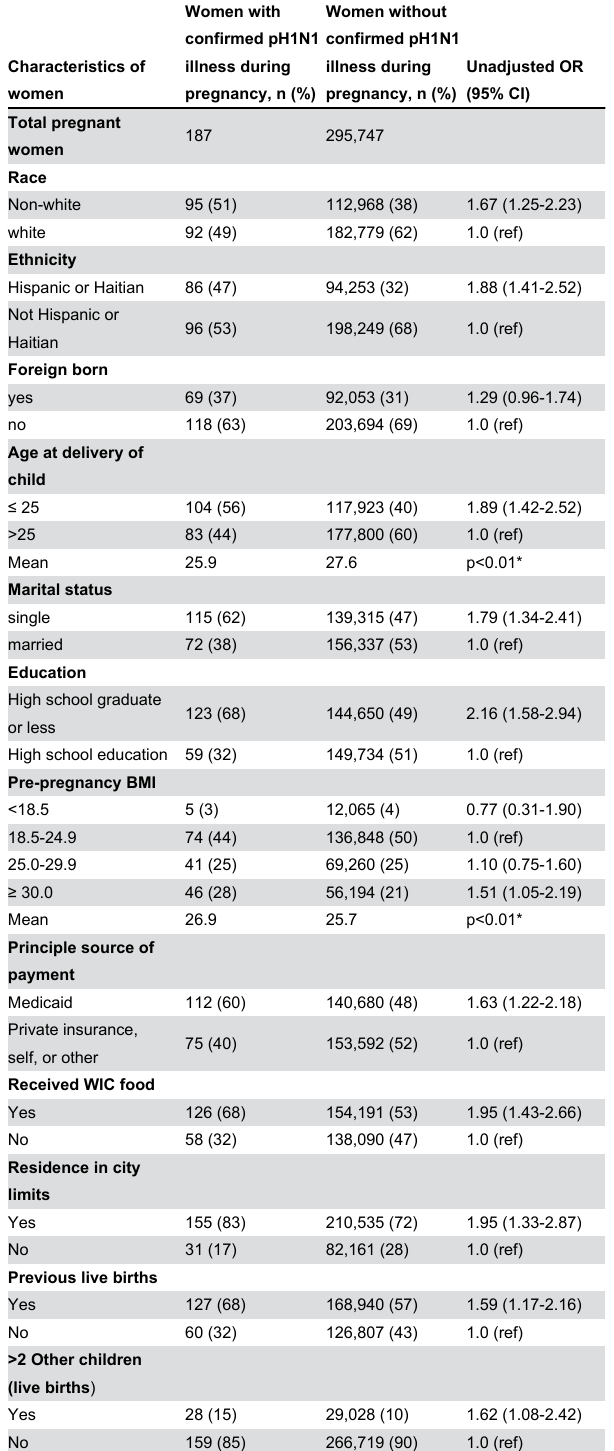
Table 1. Demographic and other characteristics of cases and non-cases of pandemic influenza illness, as ascertained from child’s birth certificate.